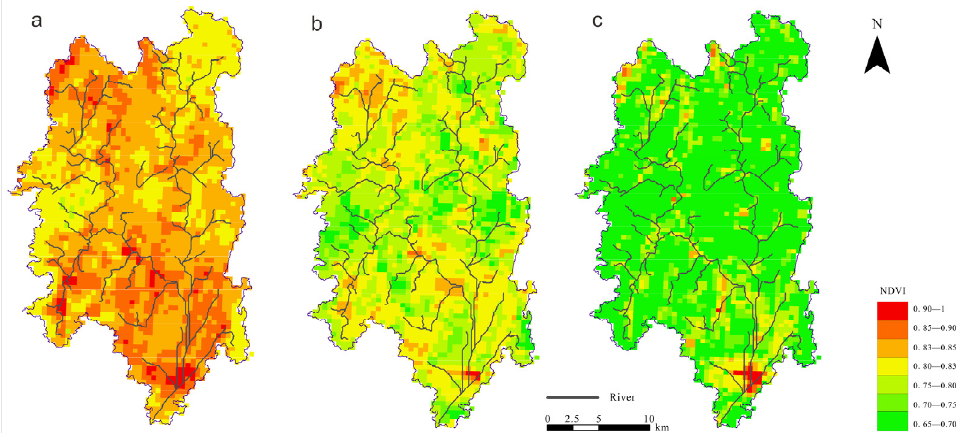
Figure 6. EVI of the study area ( a ): EGMON 1992 – 1996; ( b ): CGB1 2008 – 2012; ( c ): CGB2 2015 – 2019.